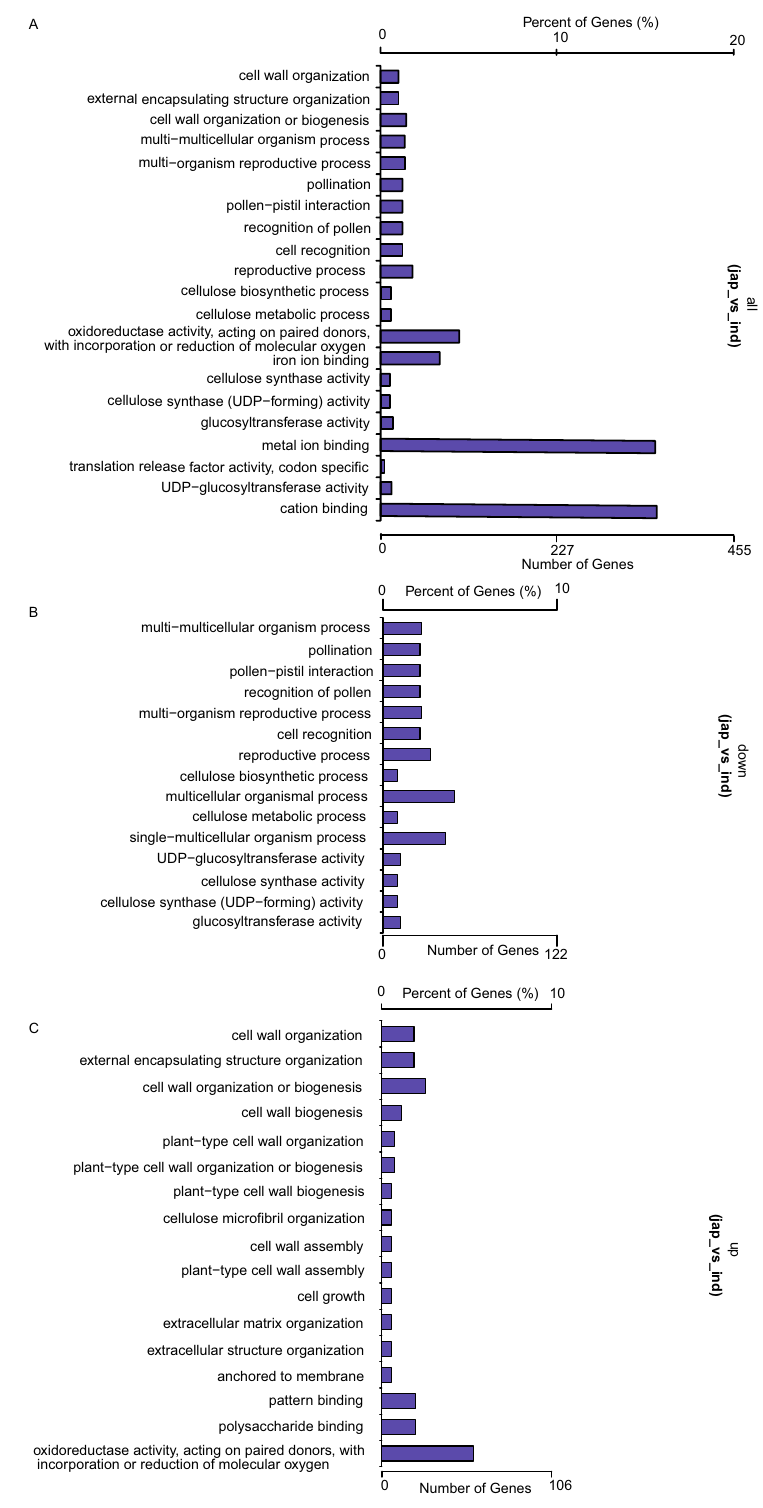
Figure 6. Histogram of Gene Ontology classifications. The letters associated with the x-axis indicate the GO categories, and the y-axis indicates the number of unigenes in each category. ( A ) GO analysis of all the DEGs. ( B ) GO analysis of the down-regulated genes. (C) GO analysis of the up-regulated genes. This figure was created using Goseq